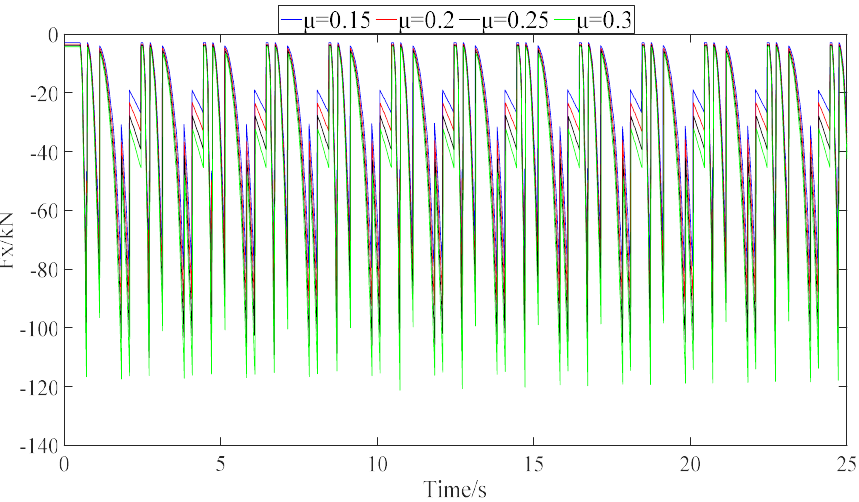
Figure 25. Time history curves of total ice force under different friction coefficients (µ).